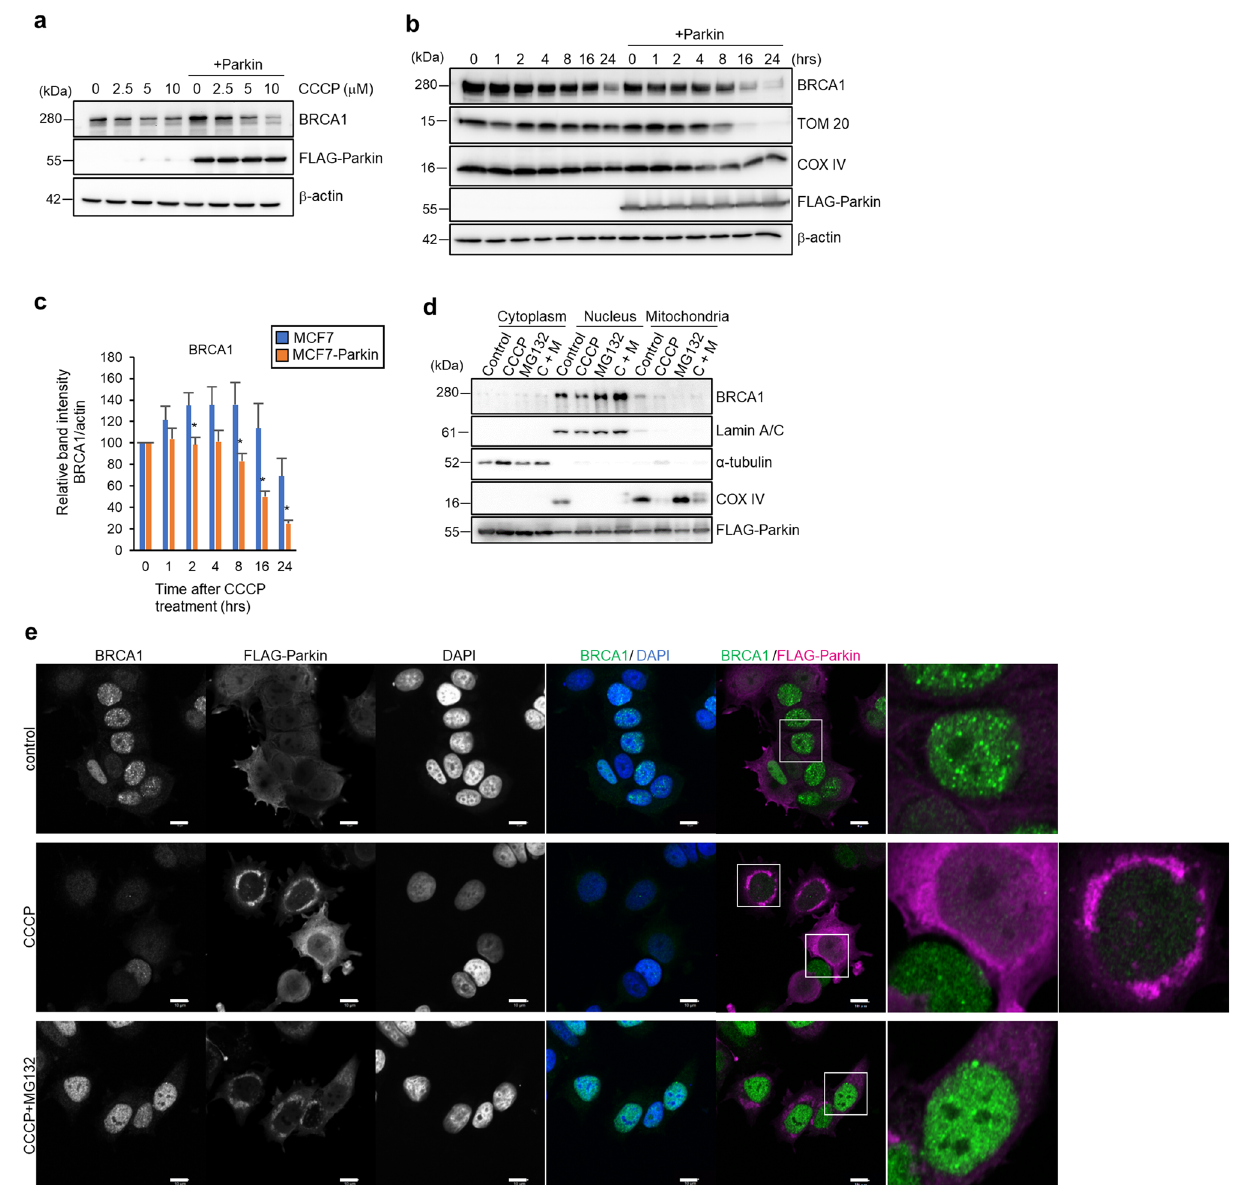
Figure 2. Parkin promotes BRCA1 degradation after mitochondrial damage via the ubiquitin–proteasome pathway and is co-localized in nucleus. ( a ) MCF7 and MCF7-Parkin cells were treated with CCCP at the indicated concentrations for 24 h, and then BRCA1 protein level was assessed by Western blotting. ( b ) Protein levels of BRCA1 as assessed by Western blotting. MCF7 and MCF7-Parkin cells were treated with 10 μM CCCP for the indicated times. Representative images from seven independent experiments are shown. TOM20 and COX IV were assessed to verify the occurrence of mitophagy. Because the overexpression of Parkin accelerates mitophagy, the degradation of TOM20 and COX IV in MCF7-Parkin cells after CCCP treatment was faster than that in MCF7 cells. ( c ) Densitometry analysis of BRCA1 in ( b ). Each band intensity was standardized against β-actin, and relative band intensities were calculated. n = 7, bar = means ± S.E., * p < 0.05 versus MCF7 at the same time point. ( d ) MCF7-Parkin cells were separated into the cytoplasmic, nuclear, and mitochondrial fractions after treatment with 0 or 10 µM CCCP and 0 or 10 µM MG132 for 24 h. Each fraction was subjected to Western blotting. Lamin A/C, α-tubulin, and COX IV were used as markers of the nuclear, cytoplasmic, and mitochondrial fractions, respectively. ( e ) Subcellular localizations of BRCA1 and FLAG-Parkin in MCF7- Parkin cells were assessed by immunofluorescence. Cells were treated with a vehicle, 10 μM CCCP, or 10 µM CCCP + 10 μM MG132 for 5 h. The treatments are indicated on the left side, and the detected proteins are indicated at the top. In the merged panels, BRCA1, FLAG-Parkin, and the nuclei are shown in green, magenta, and blue, respectively. The small boxed images are enlarged in the right panels. Scale bar = 10